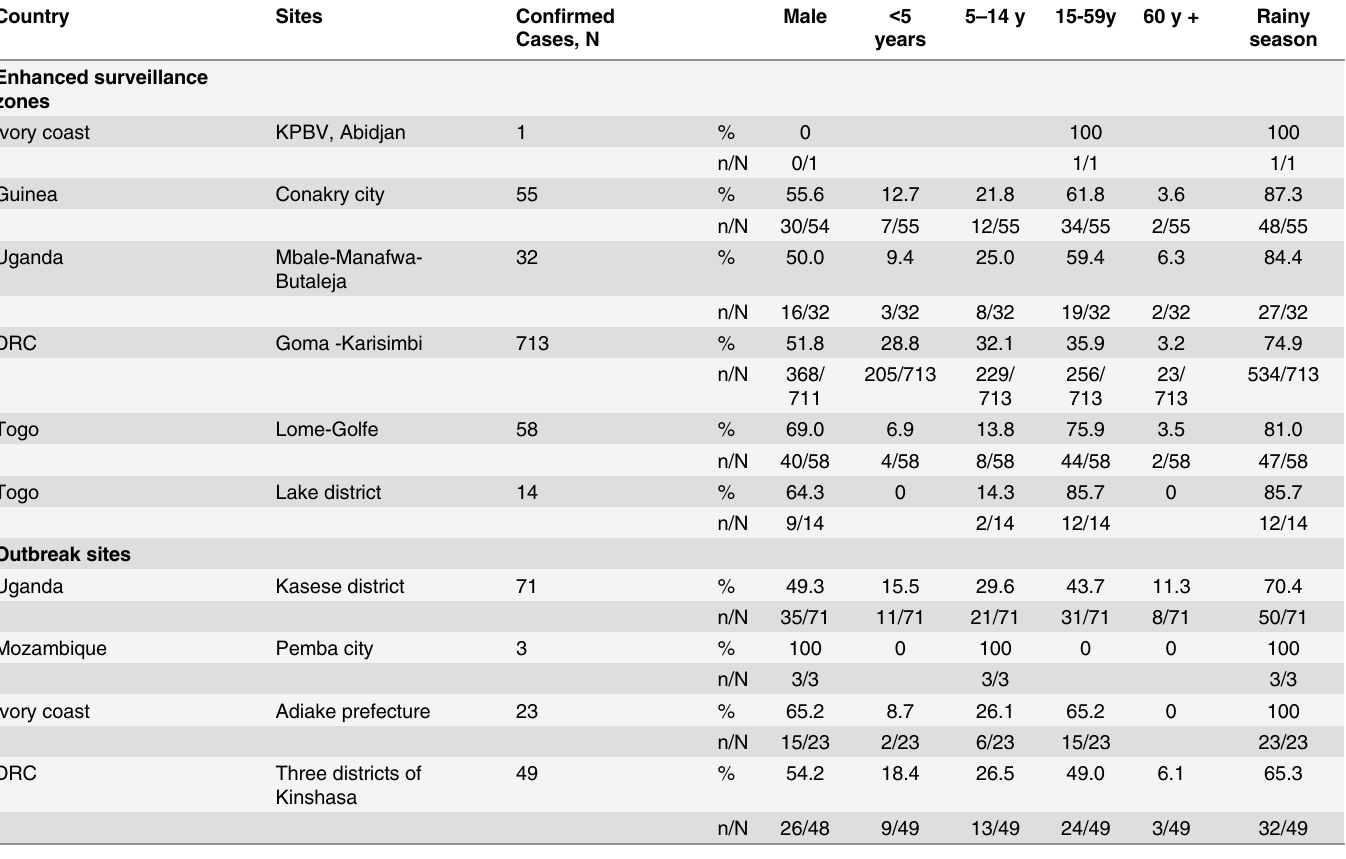
Table 3. Gender, age and season of occurrence of culture confirmed cholera cases. N = 1019. Country